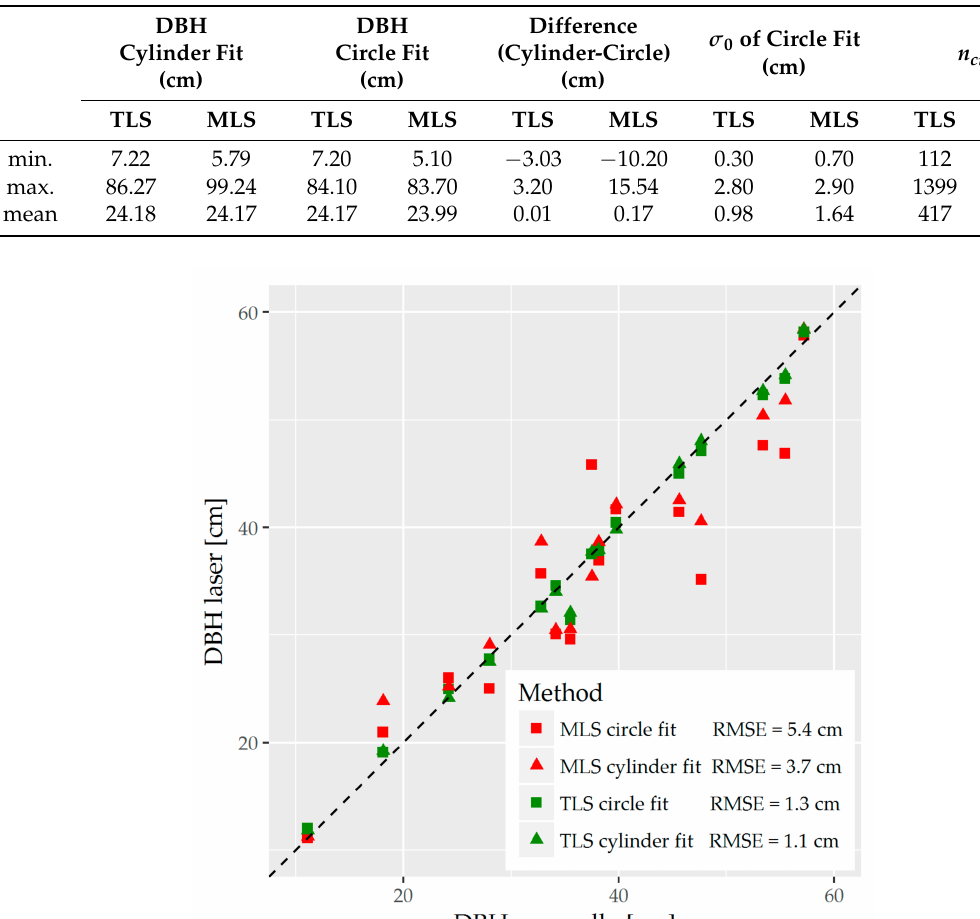
Table A2. Determined DBHs of the 22 detected TLS- and MLS-trees of plot 2. The difference results from DBH cylinder –DBH circle .